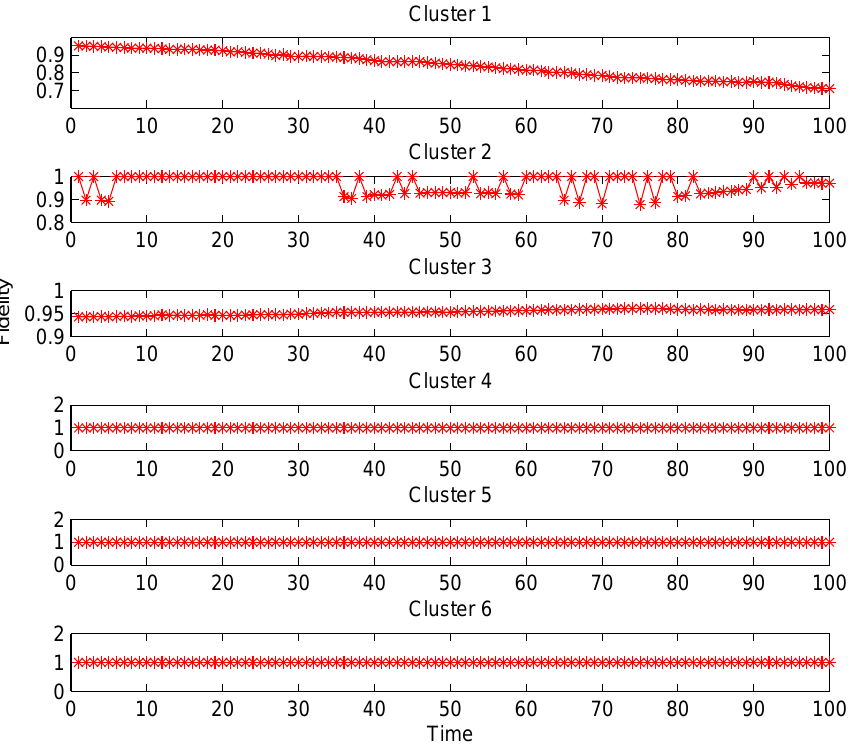
Figure 3. Fidelity curves without the dynamical adjustment of data collection